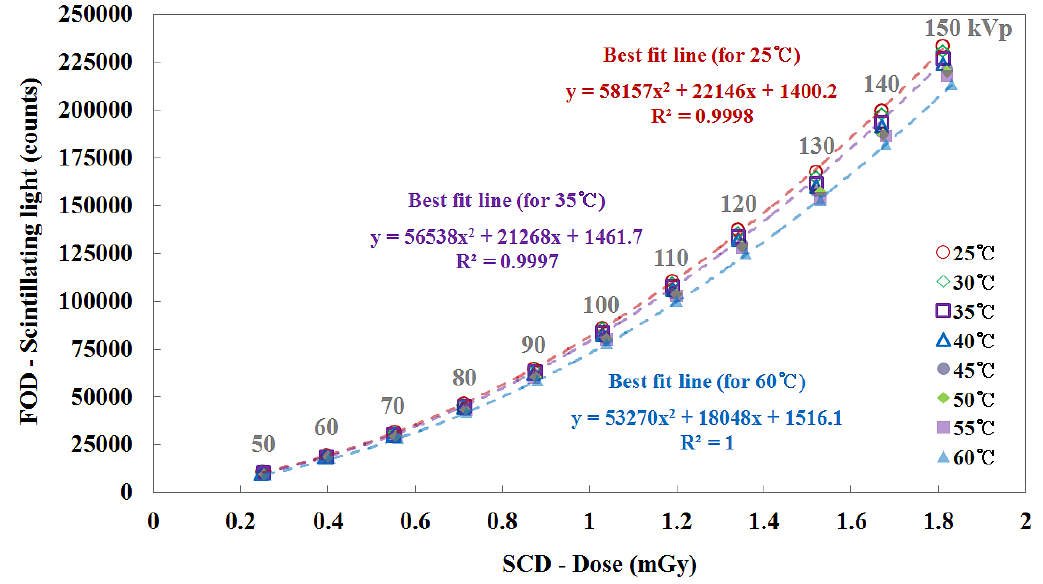
Figure 6. Relationship between the total counts of the FOD and the X-ray dose of the SCD as a function of the tube potential.